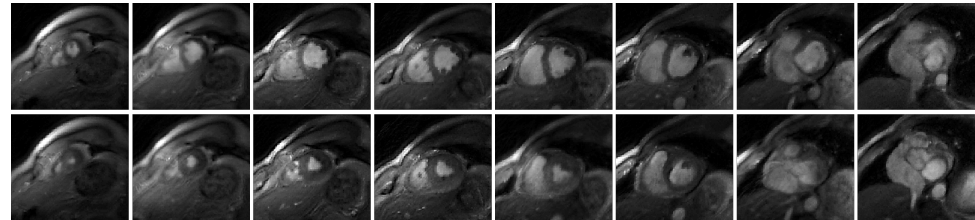
Figure 2. Showcase of the reconstruction of free-breathing and ungated cardiac MRI using the proposed deep kernel method. The eight slices are from Subject #2. The first row shows the end- diastolic phase, and the second row is the end-systolic phase.